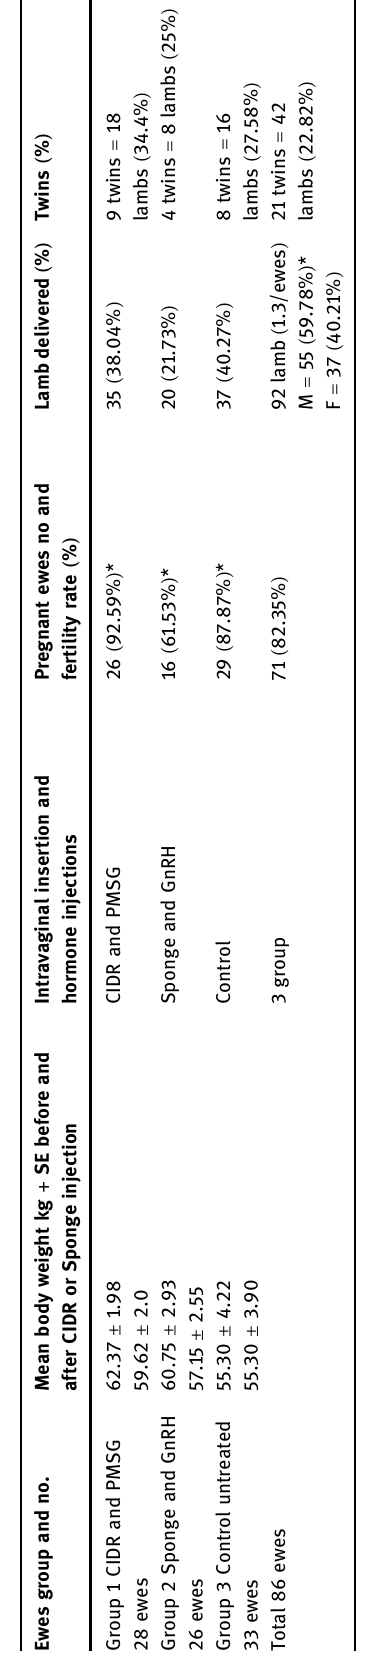
Figure 1: The o ff spring production of the three treated ewes groups ( CIDR + PMSG, Sponge + GnRH, and control ) with their lamb sex